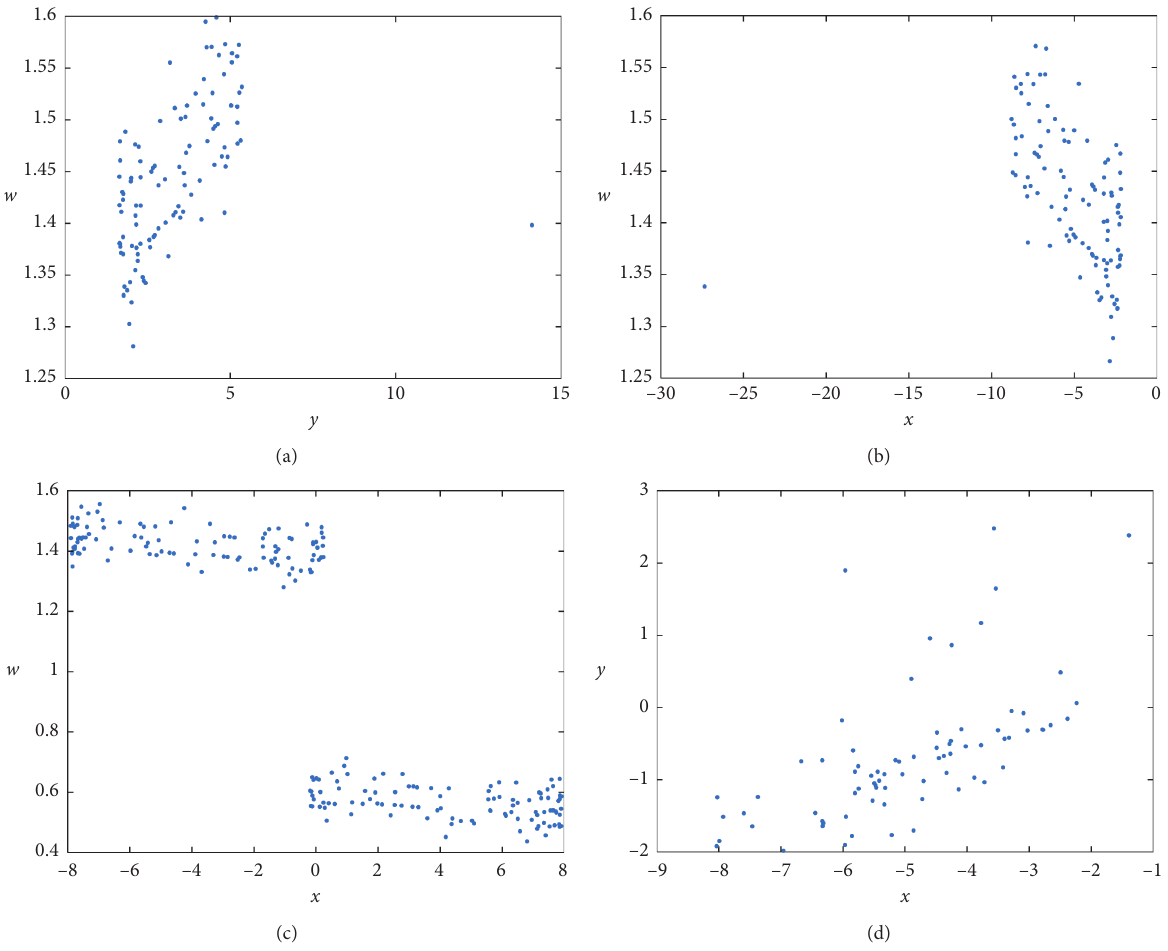
Figure 2: Poincar´e sections of system (2): (a) projection on y − w plane when Poincar´e section is x � 0, (b) projection on x − w plane when Poincar´e section is y � 0, (c) projection on x − w plane when Poincar´e section is z � 6, and (d) projection on x − y plane when Poincar´e section is w � 1 . 4.